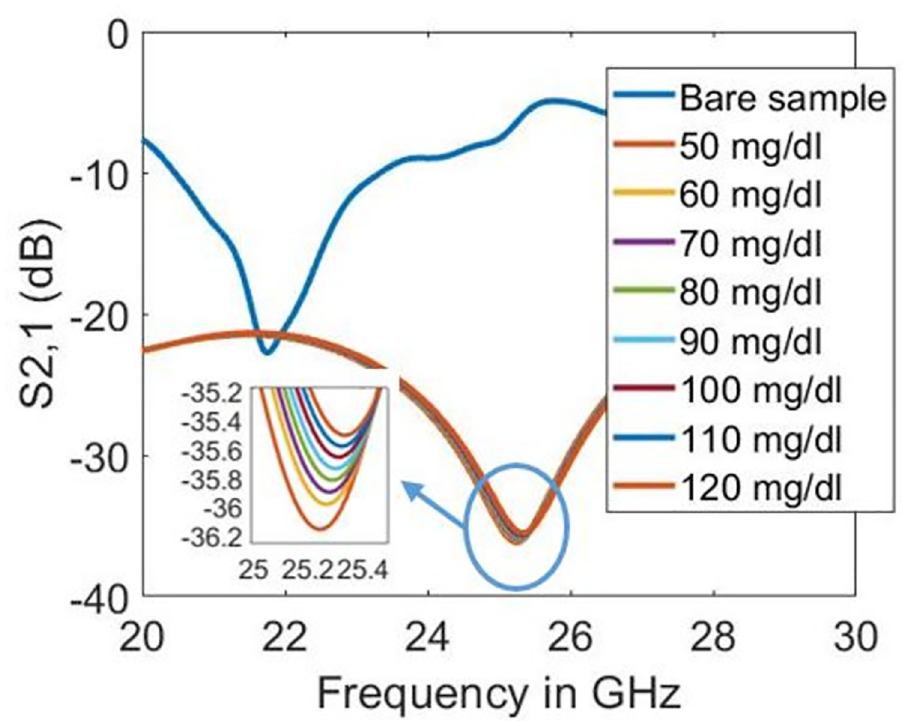
Fig 13. Transmission coefficient responses on different glucose levels with four split-rings.